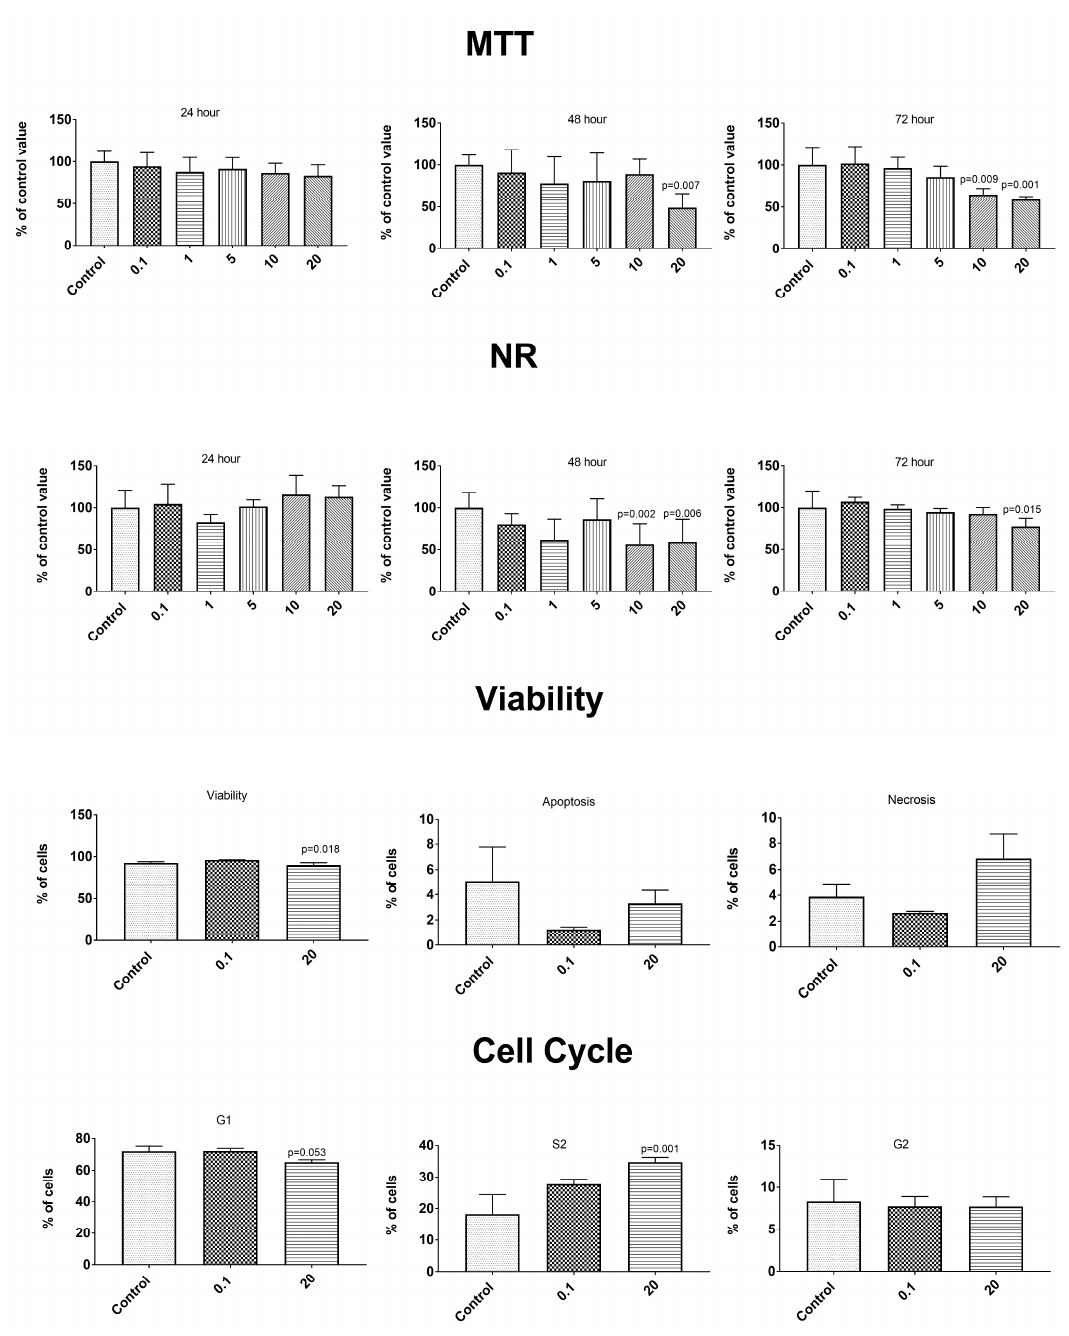
Figure 5. Impact of YE-GD (sample after the in vitro digestion of the YE-elicited lovage leaves) on cytotoxicity (MTT and NR method), type of cell death (Annex V and PI test), and phases of the cell cycle in the HPrEC ATCC ® PCS-440-010™ cell line.